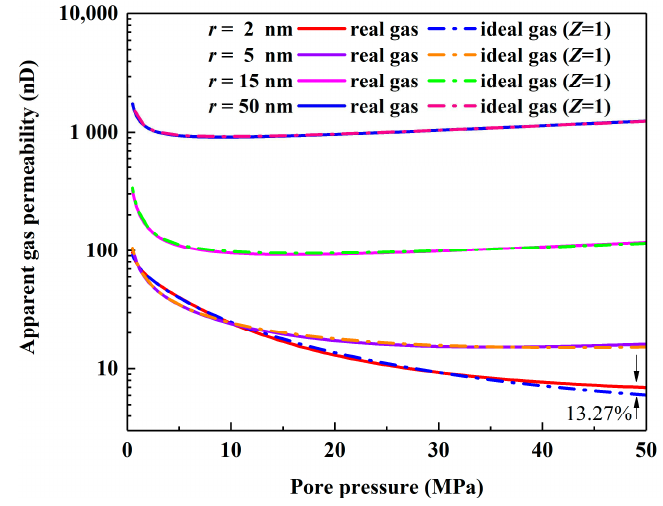
Figure 8. AGP of ORM varies with pressure at different radius.